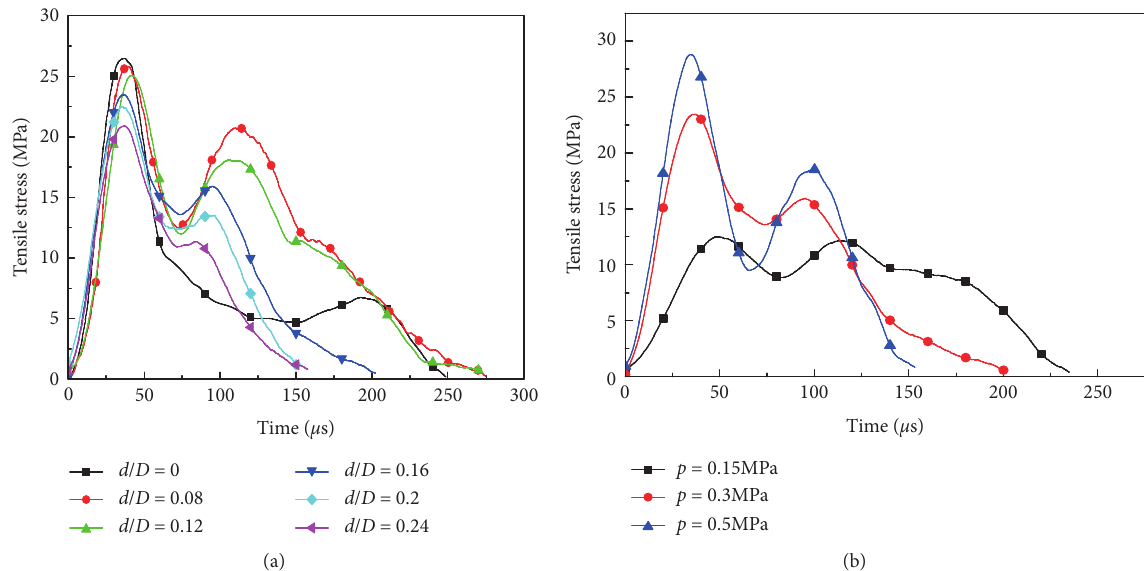
Figure 4: Tensile stress-time curves of specimens under (a) different hole diameters at the 0.3MPa pressure and (b) different pressures at the ratios of inner and outer diameter 0.16.